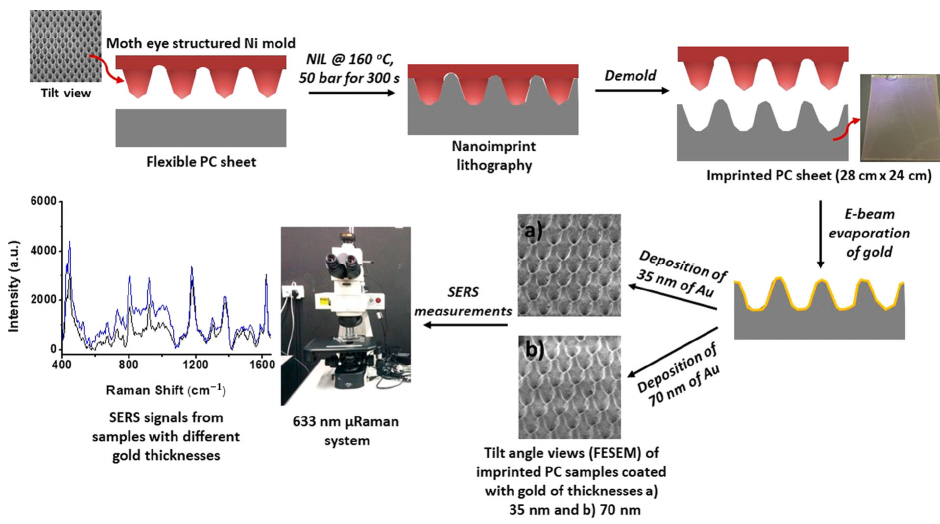
Figure 6. The schematic diagram of manufacturing Au nanocones as SERS substrate. Reproduced with permission from reference [60]. Copyright 2018 American Chemical Society.